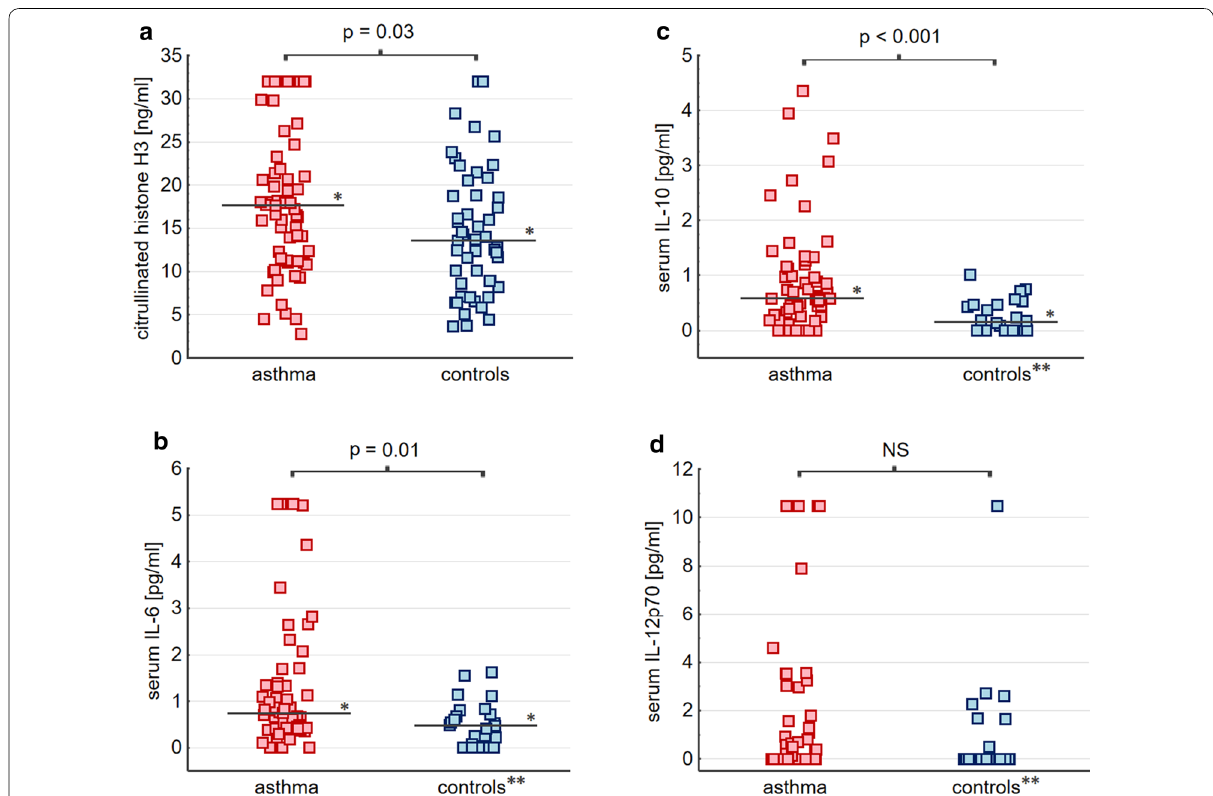
Fig. 1 Circulating H3cit and relevant serum cytokine concentrations in asthma and control subjects. * Median value. ** Results available in 25 (50%) of control subjects. Serum H3cit was above the limit of detection (LoD) in all subjects studied ( a ). Serum IL‑6 was above the LoD in 56 (93.3%) asthmatics and 18 controls ( b ). Serum IL‑10 was above the LoD in 51 (85.0%) asthmatics and 14 controls ( c ). Serum IL‑12p70 was above the LoD in 27 (45.0%) asthmatics and 7 controls ( d